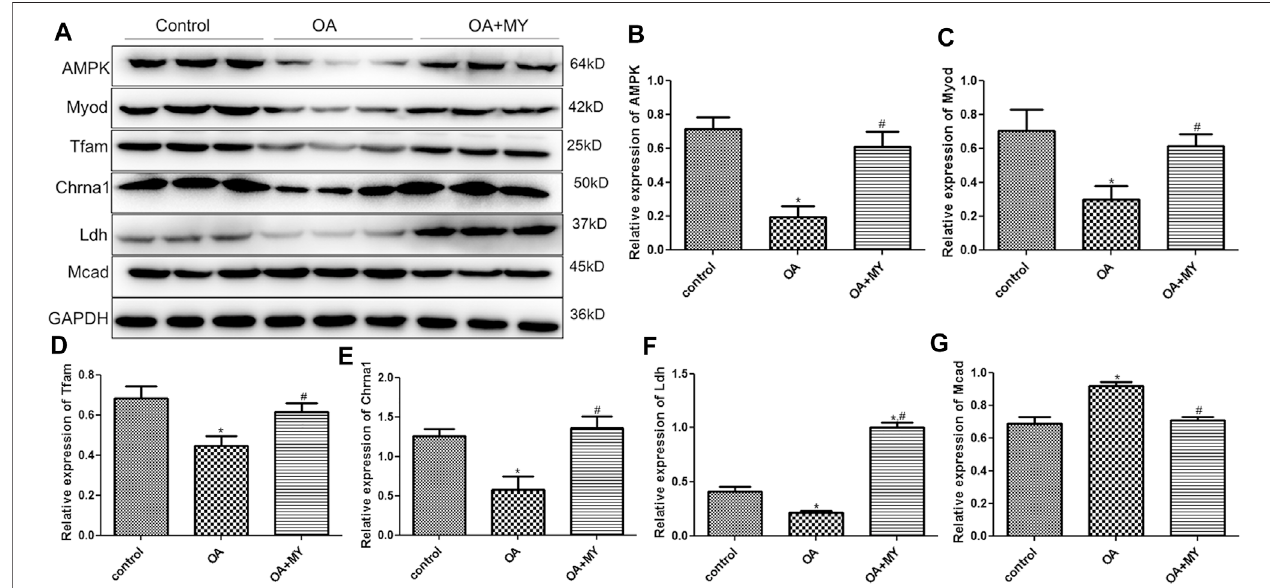
FIGURE 7 | Effects of MY on the expressions of related proteins in the tibia muscle of different groups. (A) Protein bands visualized by western blotting. Protein expression of AMPK (B) , Myod (C) , Tfam (D) , Chrna1 (E) , Ldh (F) , and Mcad (G) . * p < 0.05, compared with the control group; # p < 0.05, compared with the OA